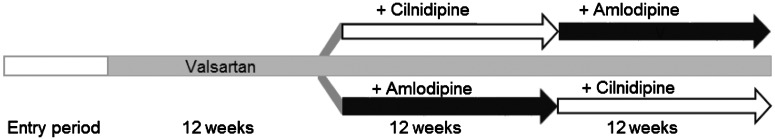
The flow chart of the study of the comparison study of two types of Ca channel blockers on the top of ARB